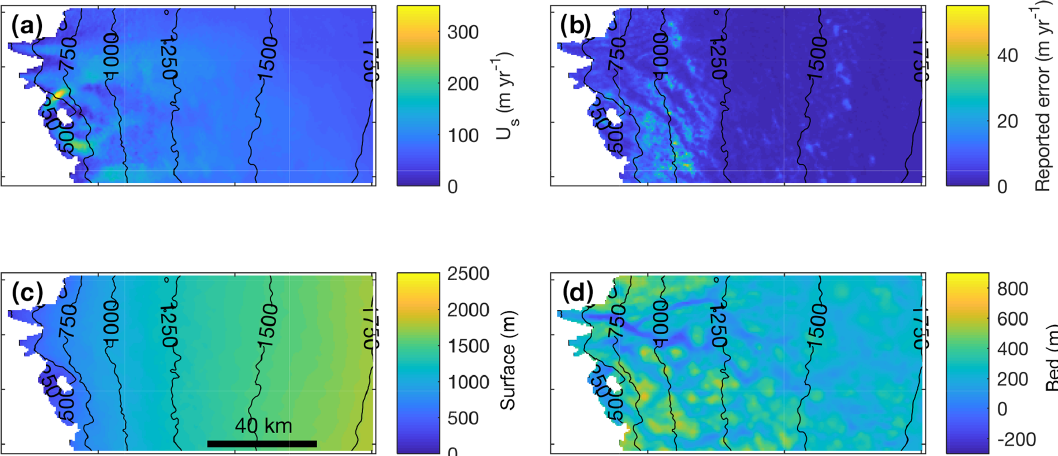
Figure 2. (a) Velocity measurements from the MEaSUREs Greenland Ice Sheet Velocity Map at 500m resolution for the Russell Glacier area (Joughin et al., 2010a, b). (b) Reported error for the measurements. (c) Surface topography from BedMachine2 dataset (Morlighem et al., 2014, 2015) reinterpolated to 500m. (d) Basal topography at same resolution.